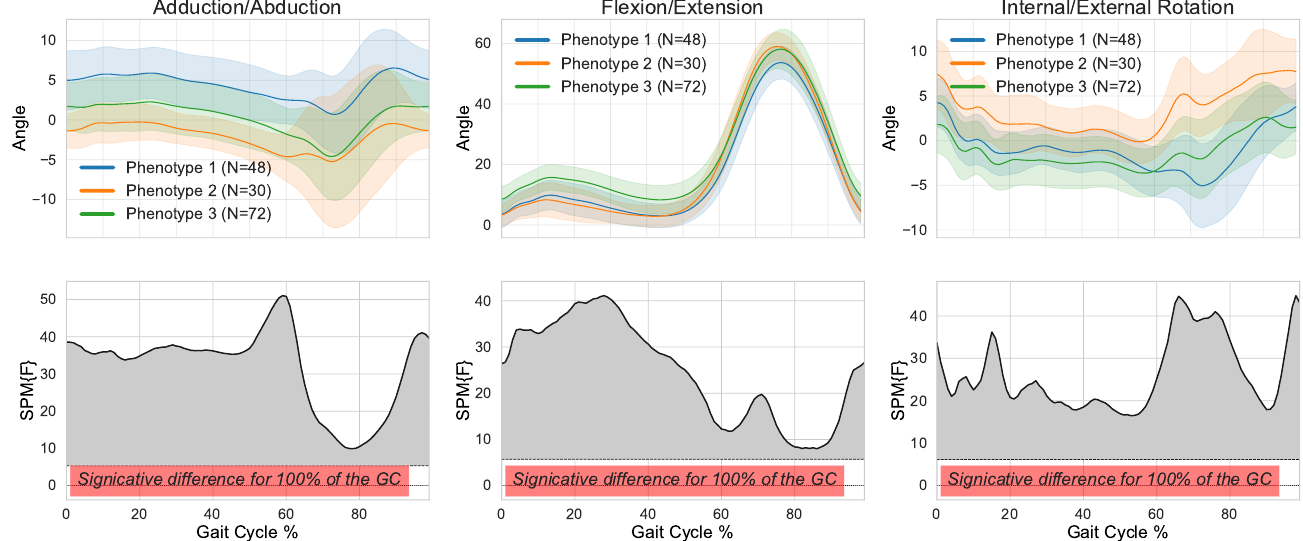
Figure 4. The three identified phenotypes based on global representation (Line 1) and the corresponding SPM{t} with a significance threshold α = 0.05 (Line 2). The gray area indicates the percentage of the gait cycle for which the three phenotypes are different.